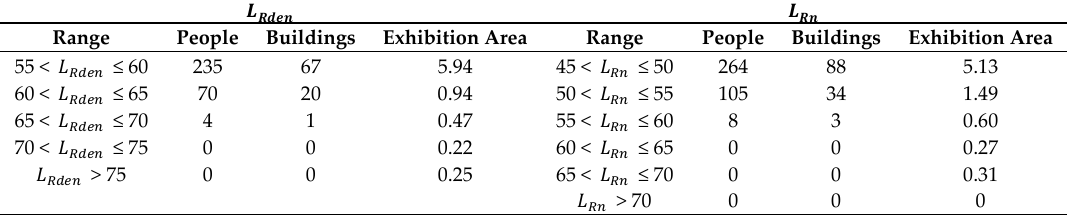
Table 3. Estimated number of people and buildings, and the exhibition area (km 2 ) for (cid:1838) (cid:3019)(cid:3031)(cid:3032)(cid:3041) and (cid:1838) (cid:3019)(cid:3041) . (cid:2168) (cid:2174)(cid:2186)(cid:2187)(cid:2196) (cid:2168)